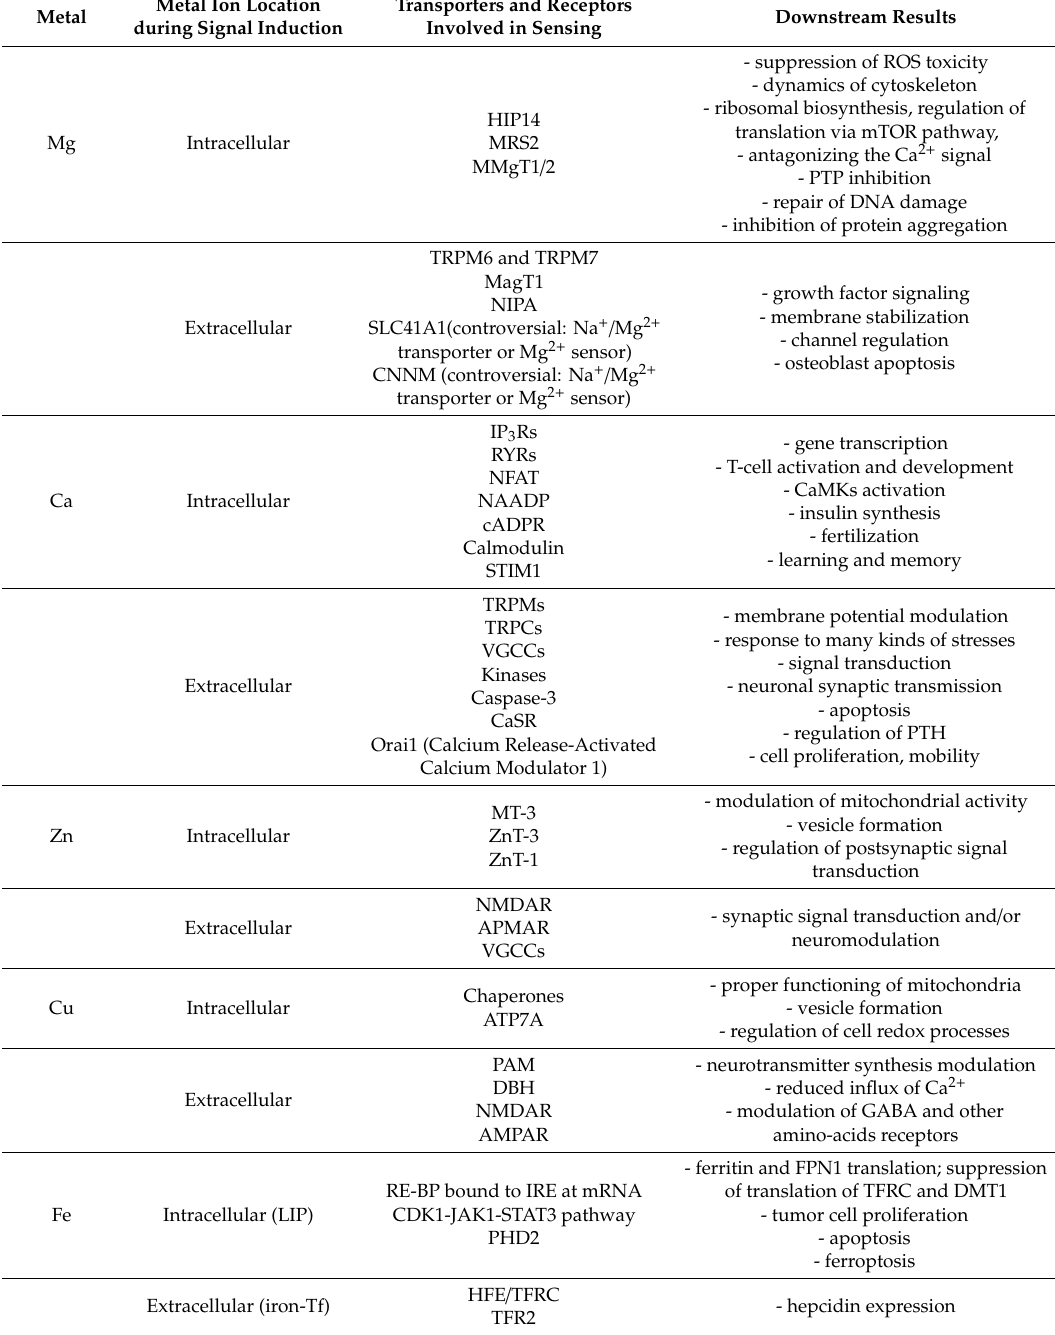
Table 1. Summary of described signaling functions of chosen metal